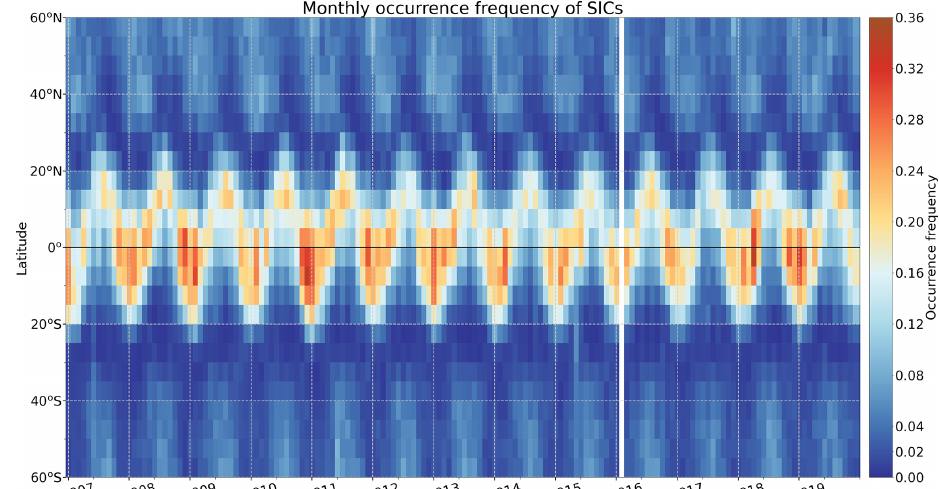
Figure 2. Monthly occurrence frequencies of SICs in the latitude band of 5 ◦ from 2007 to